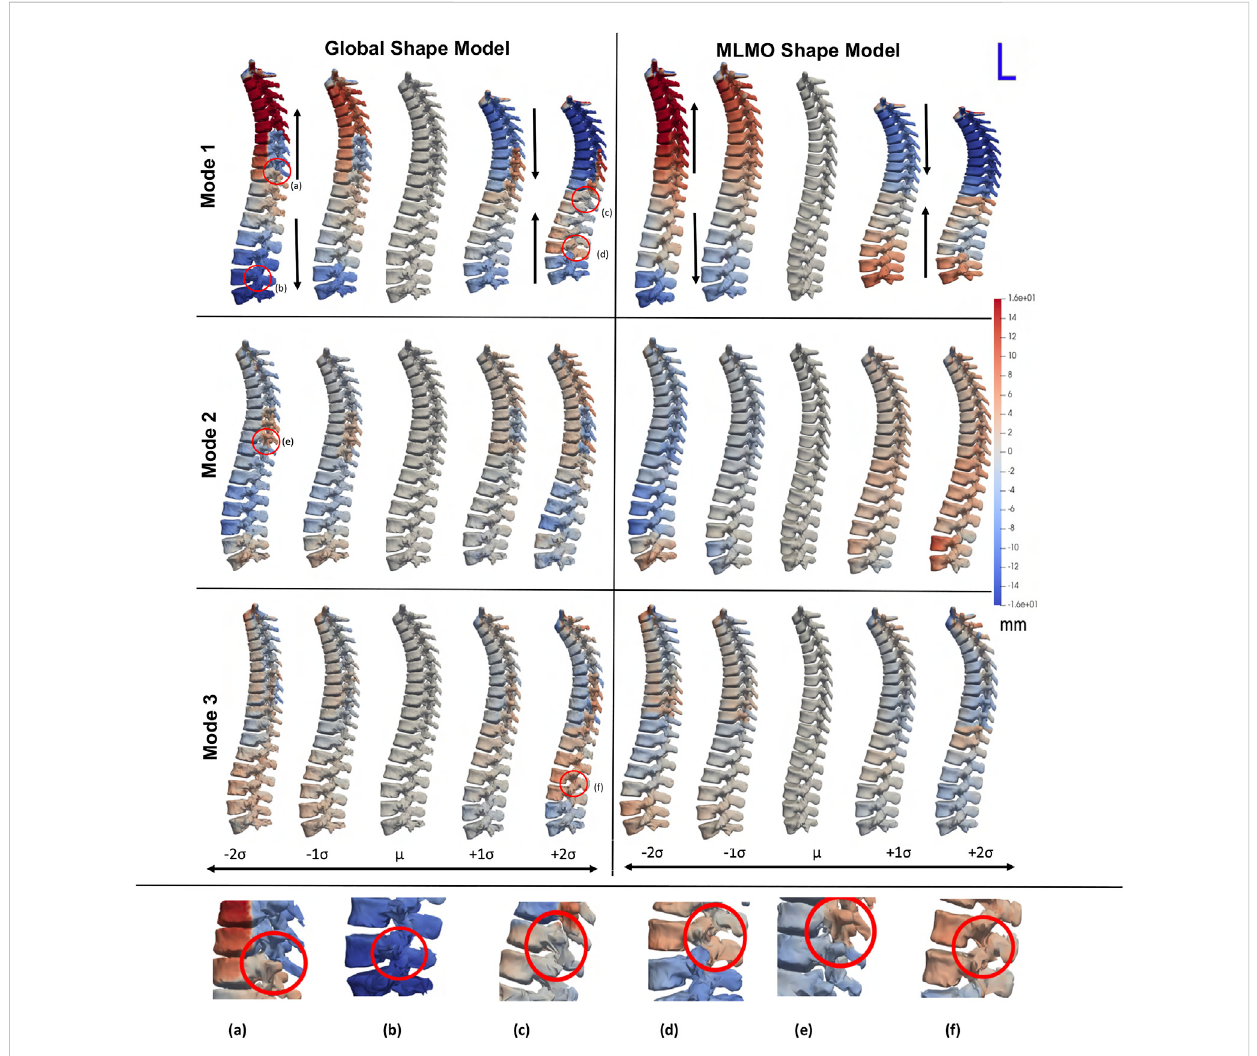
FIGURE 2 PCA modes of variation computed in the shared subspace for the spinal column dataset. The color map shows the distance of each mode from the mean shape. Some of the anatomical inconsistencies are highlighted in red circles labeled from (A – F)